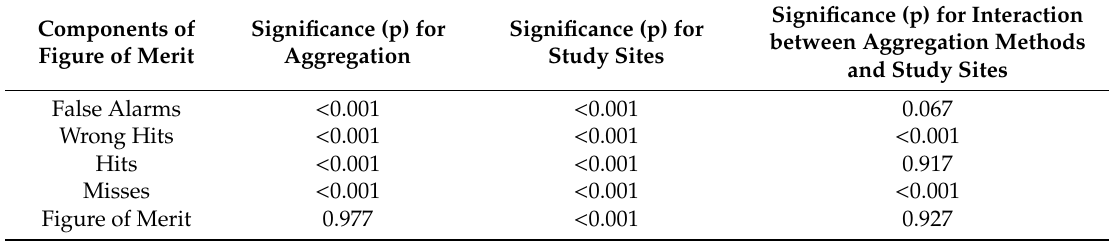
Table 3. Result of the Kruskal-Wallis test of the Figure of Merit components by aggregation methods (H 0 : medians of FOM components are equal). Significance (p) Aggregation